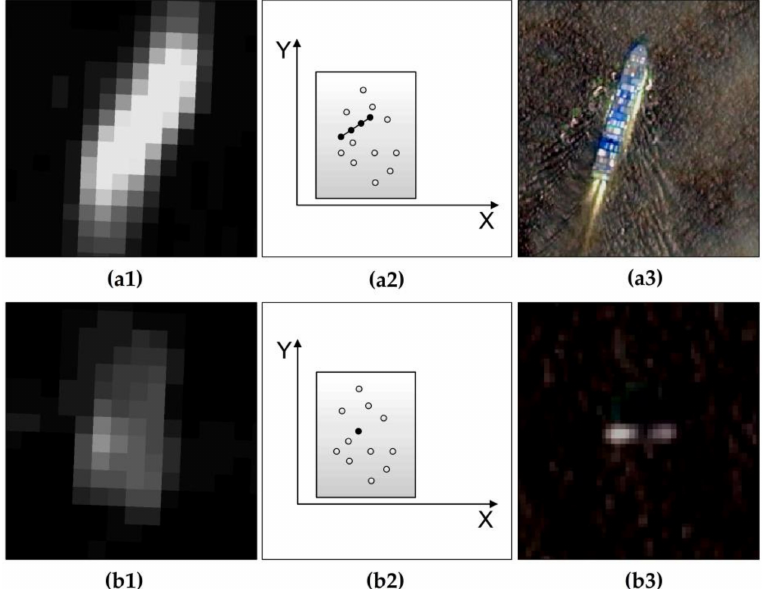
Figure 11. Influencing results of dim targets on the Hough transform. ( a1 , b1 ) are images of ships a and b in GF-3, respectively; ( a2 , b2 ) represent expressions of the pixel coordinate point sets of ships a and b in Hough space, respectively; ( a3 , b3 ) are images of ships a and b in GF-1/2,